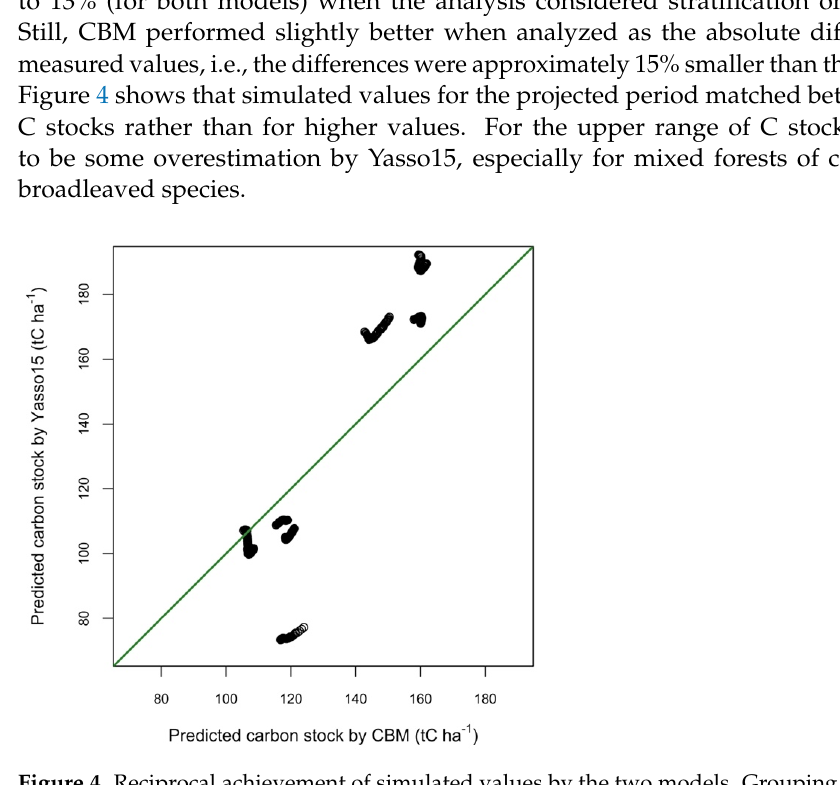
Figure 3. Measured and modeled initialized total C stock (tC ha − 1 ) on forest types ( a ) and on CLUs ( b ). Forest types and CLUs are represented following the altitude increase, from left to right. Decreasing number in the CLU indicates increase in mean annual temperature. See the abbreviations for the forest types in Table 1.